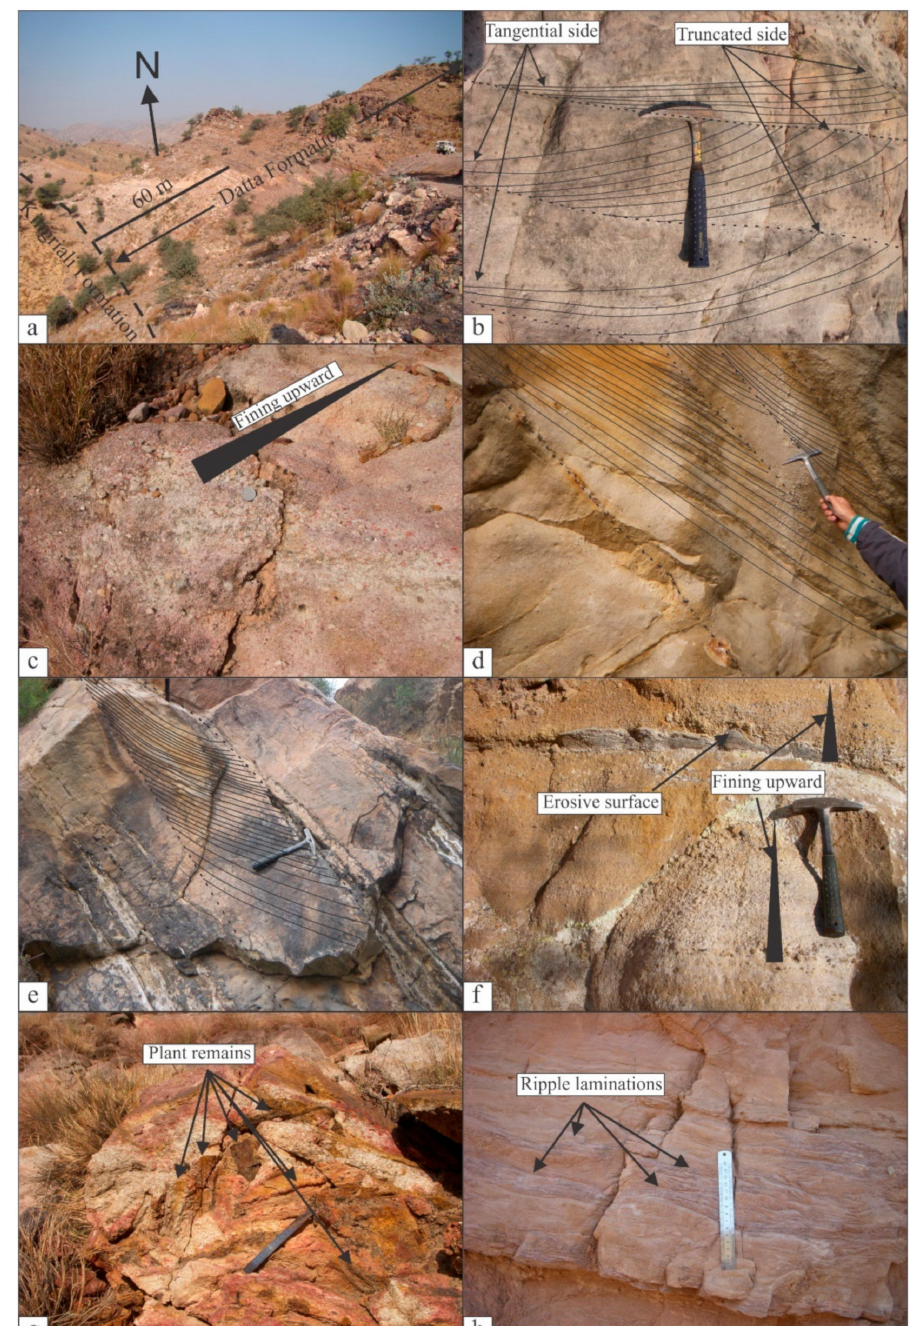
Figure 4. Representative field photographs showing: ( a ) an overview of the upper part of the Kingriali Formation and the Datta Formation in Zaluch Nala; ( b , d , e ) cross bedding (dominantly trough cross bedding) with the tangential and truncated side labeled in the Datta Formation at Kasanwala, Kaowaali, and Nammal Gorge, respectively; ( c ) quartz-rich conglomerate in the Datta Formation at the Kasanwala section; ( f ) laminated siltstone with erosive upper bedding plane and fining upward quartz rich pebbly sandstone in the Datta Formation at Nammal Gorge; ( g ) plant remains in pebbly sandstones of the Datta Formation at Kasanwala; and ( h ) ripple-laminated fine grained sandstone in the Datta Formation at Gulla